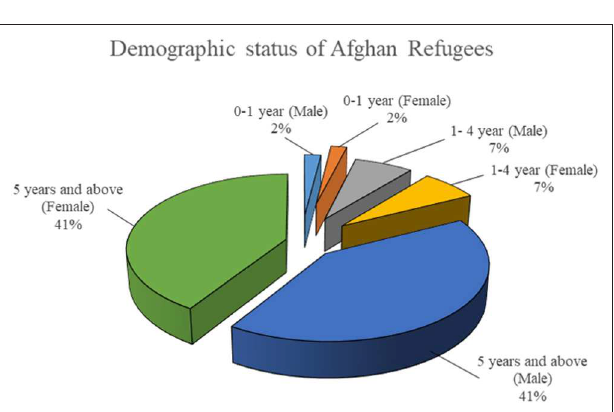
FIGURE 2 | Demographic status of Afghan refugees for year 2012 to 2018.